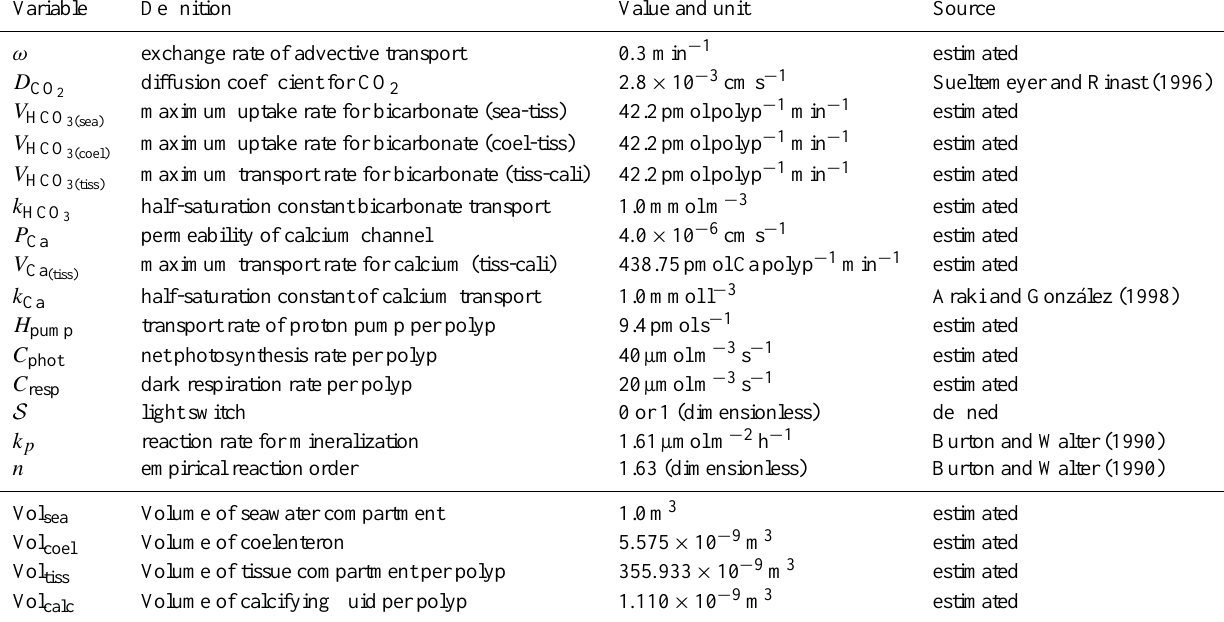
Table 2. Model parameters.